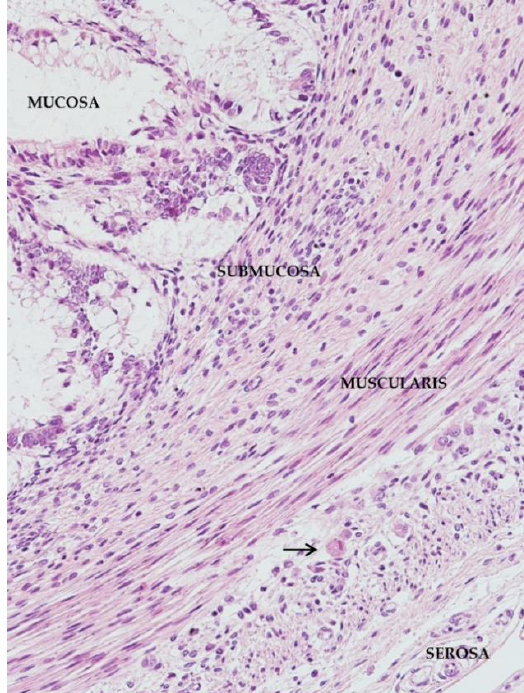
Figure 5. Whole section of the wall of large bowel from the mucosa (top left) to the serosa (bottom right). A cytomegalic cell is present (arrow) within the Auerbach’s plexus (HE staining;